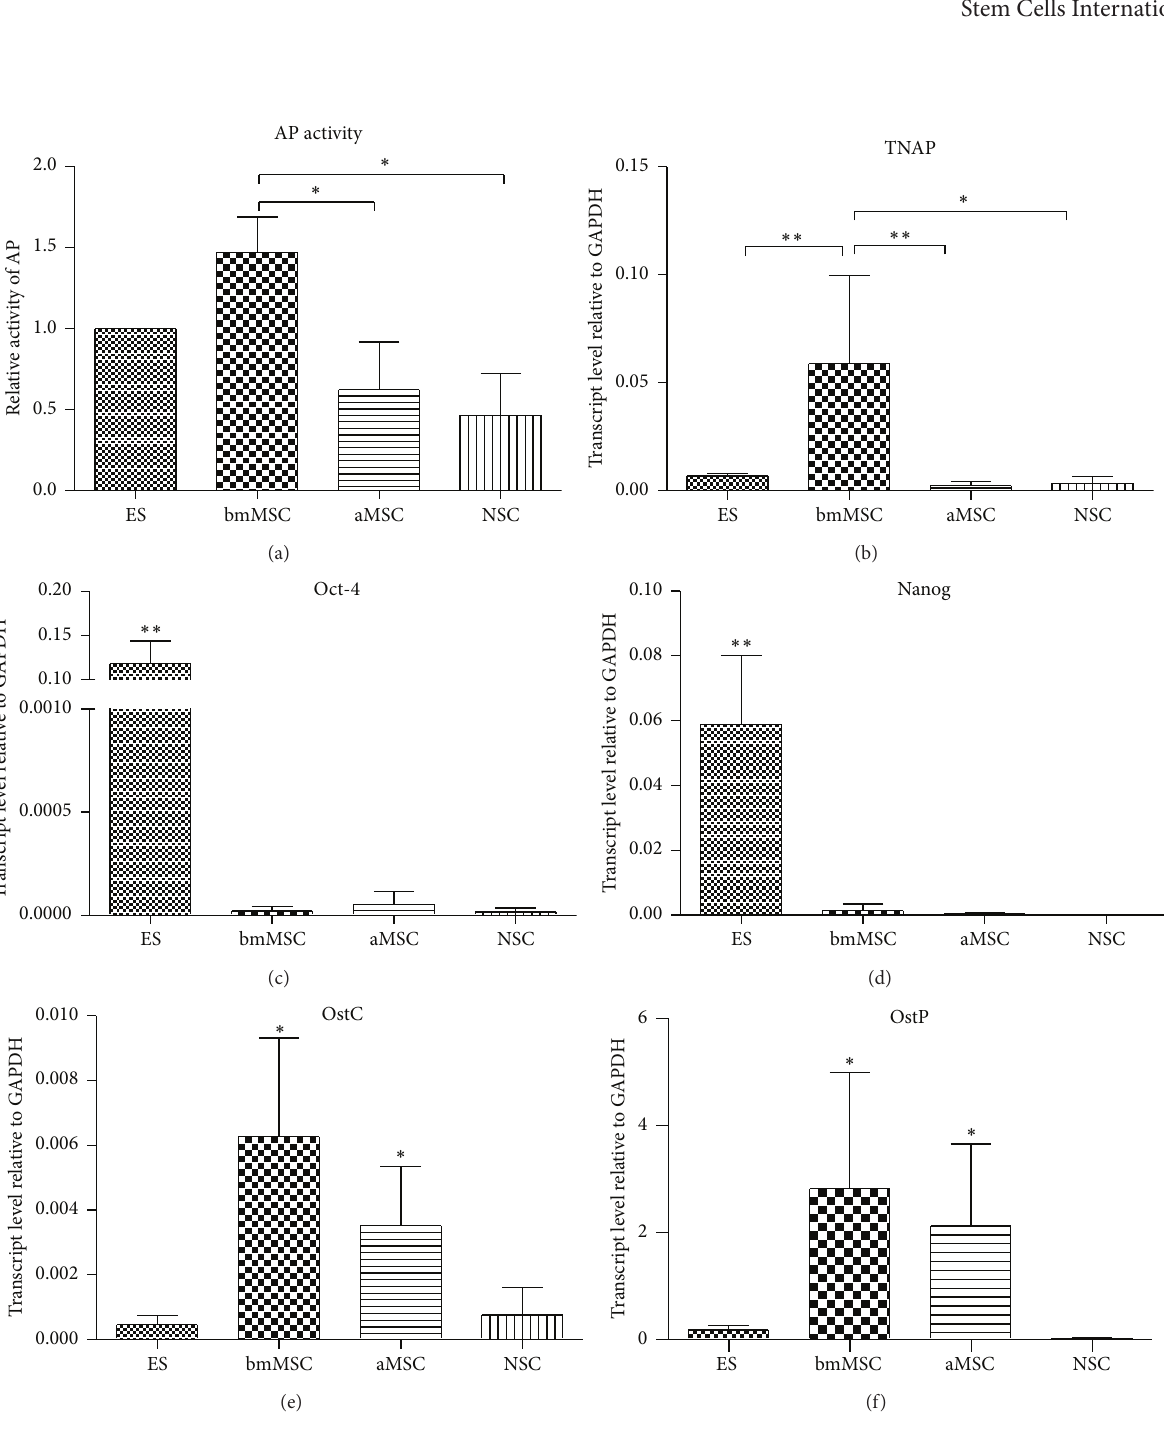
Figure 1: Relative alkaline phosphatase activity (a) and mRNA expression of TNAP ((b) qRT-PCR) in various stem/progenitor cells. Bone marrow-derived MSC (bmMSC) has both high AP activity and TNAP expression, followed by ES cells. Relative expression (qRT- PCR) of common pluripotent (Oct-4 (c) and Nanog (d)) and osteogenic (Osteocalcin, OstC (e) and Osteopontin, OstP (f)) genes. A high level of Oct-4 and Nanog documented the real pluripotent status of ES cells. A higher expression of OstC and OstP mRNA in bmMSC documented their osteogenic properties/lineages specification. (ES: mouse embryonic stem cells; NSC: neural stem/progenitor cells; bmMSC: bone marrow mesenchymal stem cells; aMSC: adipose tissue mesenchymal stem cells). Details of the presented assay may be found in our previous work [9, 77]. Primers and conditions for OstC and OstP were as follows: OstC: 5 󸀠 -CTTGGGTTCTGACTGGGTGT-3 󸀠